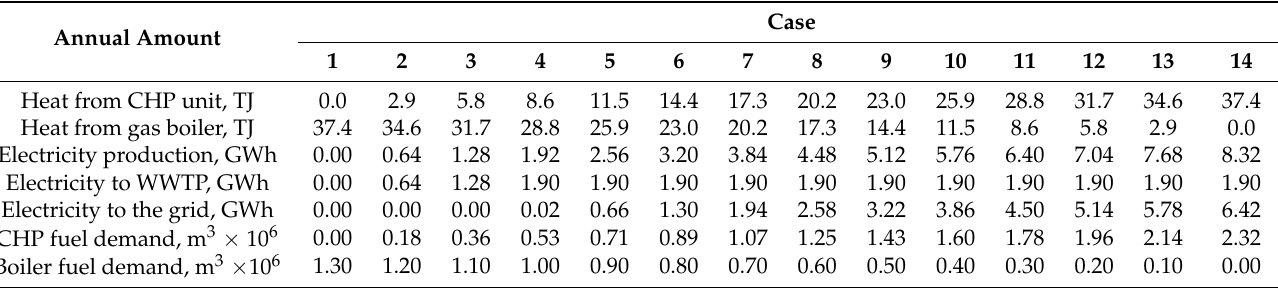
Table 3. Chosen operation data of the analyzed cases of heat source